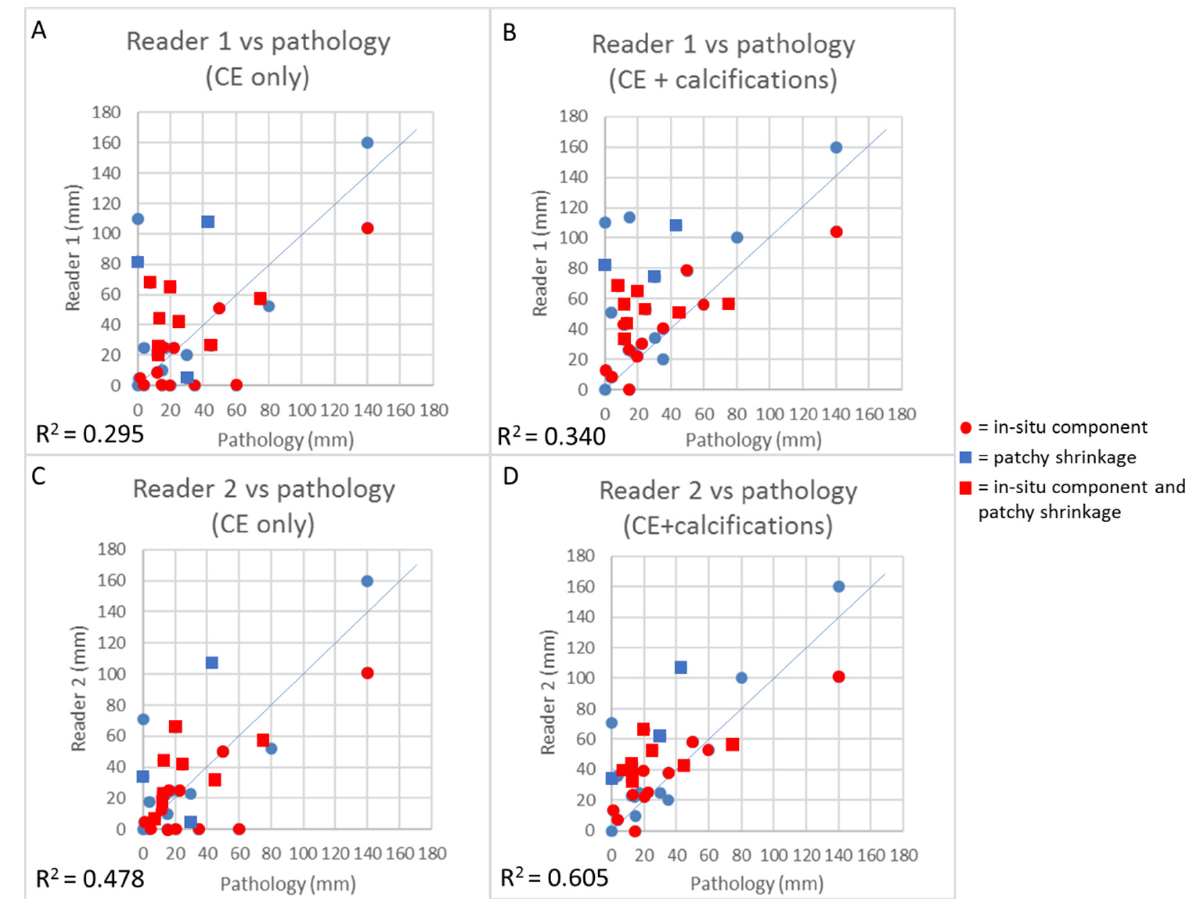
Figure 3. Linear regressions with respective R squared coefficients of CEM size measurement with pathology size measurement, respectively, for Reader 1 considering CE only ( A ), for Reader 1 considering CE + calcifications ( B ), for Reader 2 considering CE only ( C ), and for Reader 2 considering CE + calcifications ( n = 31) ( D ). Squares represent cases with patchy shrinkage. Red dots and squares represent cases with in situ component in the residual tumor bed.